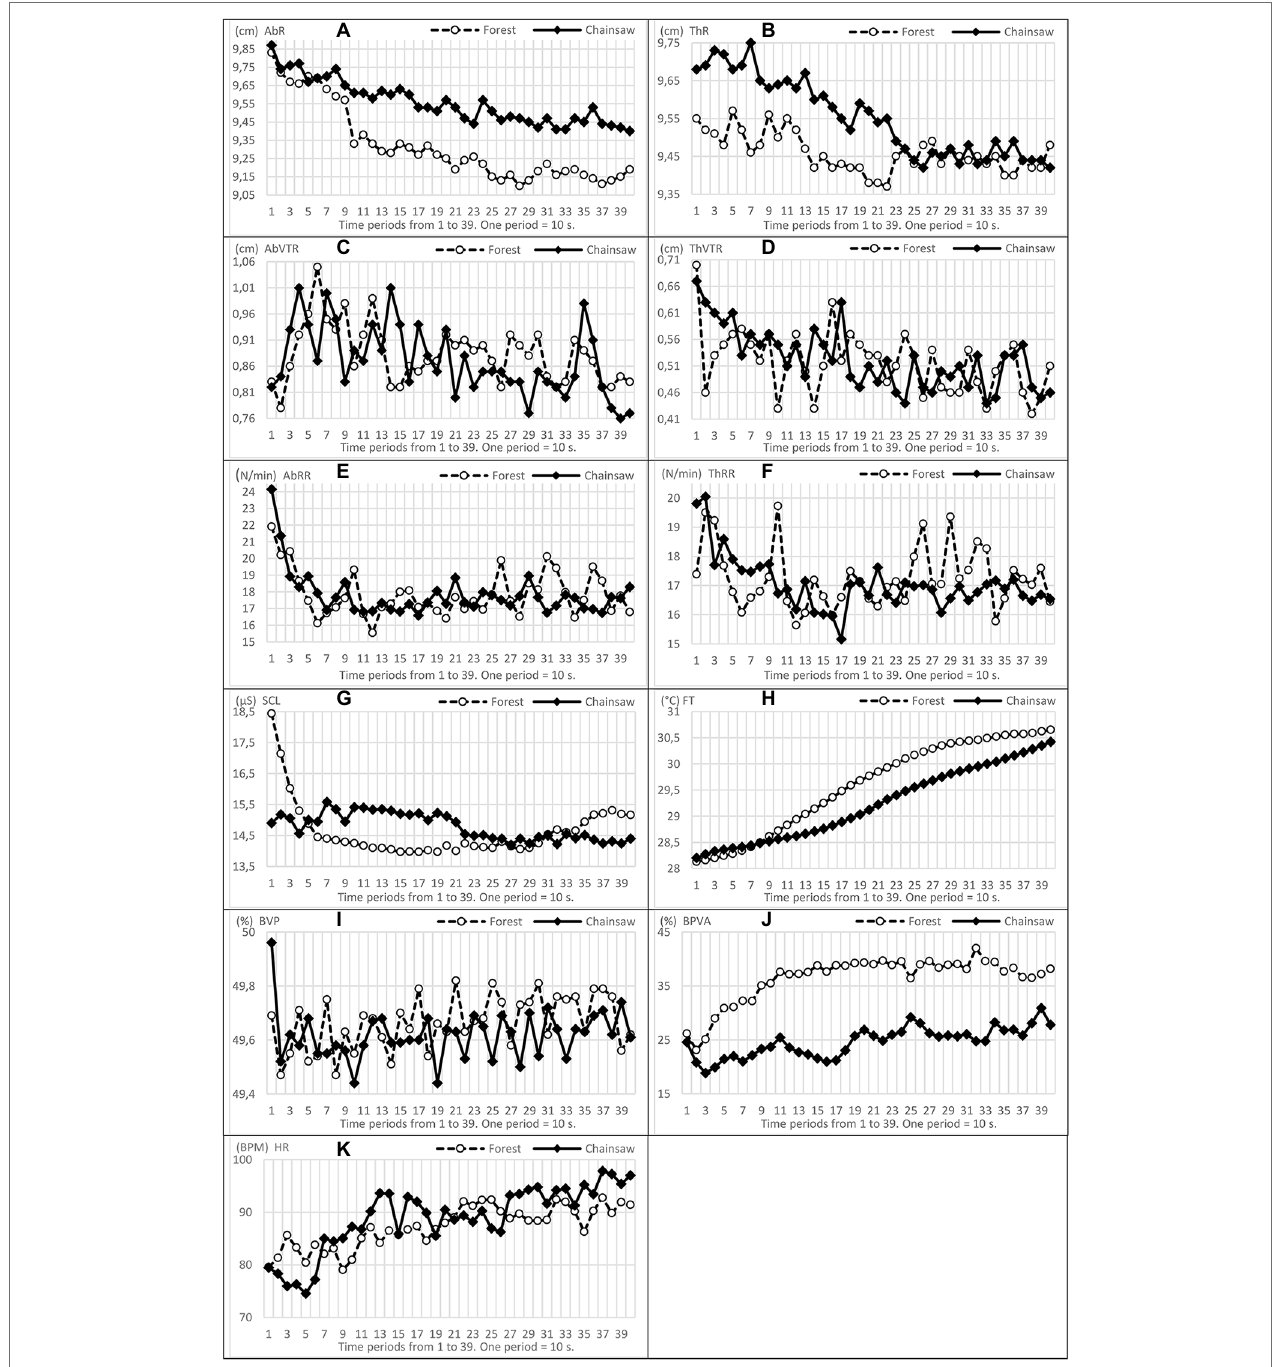
FIGURE 3 | Trends in oscillations, mild and conspicuous and ascending/descending tendencies of the means of physiological functions (A–K) . Time axis is divided into periods from 1 to 39, where one period lasts 10 s (period 39 corresponding to the end of measurements in 390